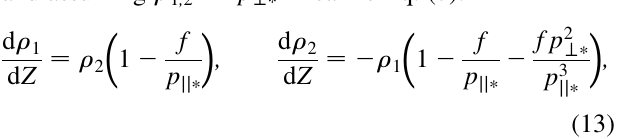
ffiffiffiffiffiffiffiffiffiffiffiffiffiffiffiffiffiffiffiffiffiffiffiffiffiffiffiffiffi